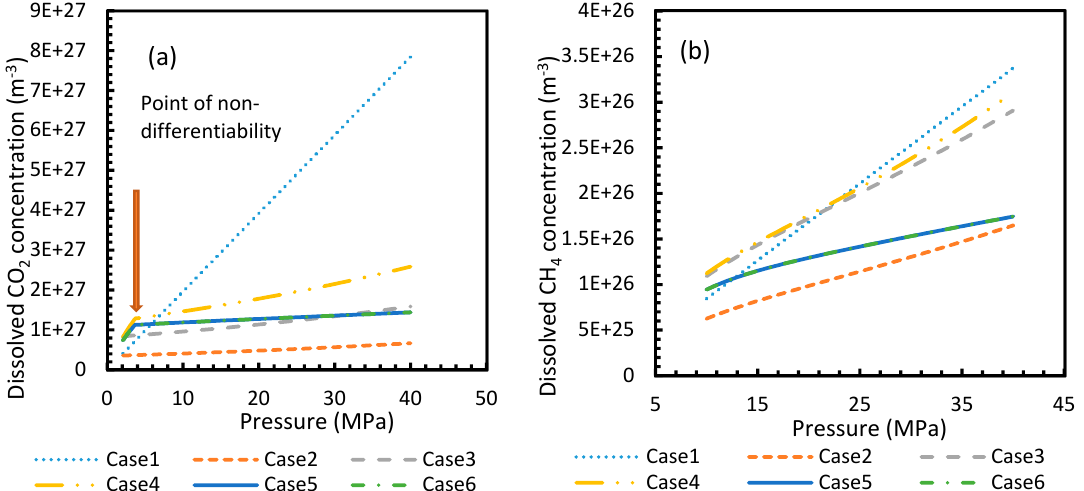
Figure 3. Profiles of dissolved gas concentration for CO 2 ( a ) and CH 4 ( b ) in aqueous solution under isothermal conditions at reference temperature 273.2 K. Points of non-differentiability can be viewed in Cases 4, 5 and 6; which are absent in Cases 1, 2 and 3. Values of Case 5 and 6 overlapped with each other.